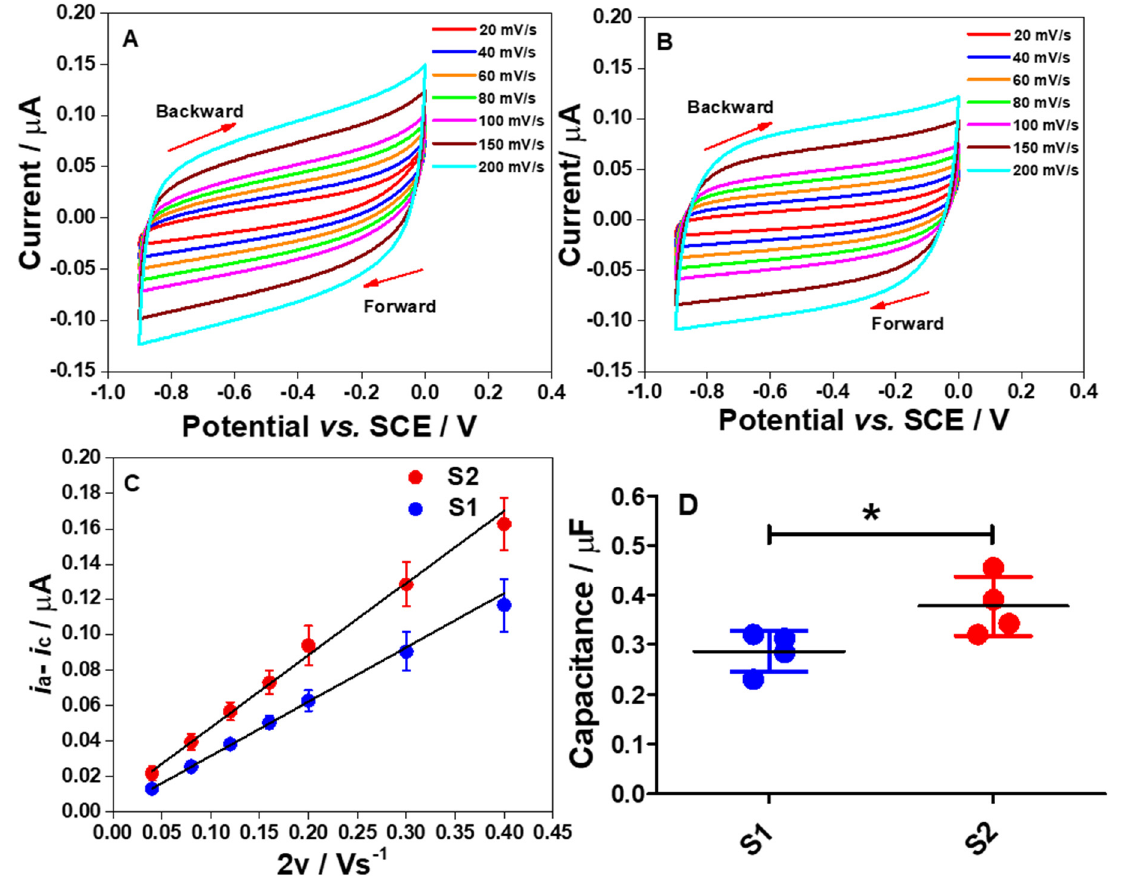
Figure 5. Cyclic voltammograms of S1 ( A ) and S2 ( B ) electrode strips in a purged 0.1 M PB solution of pH 7 at different scan rates from 20 to 200 mV s − 1 . Both electrodes were measured from 0 to − 0.9 V vs. SCE. ( C ) The plots of ∆ i vs. 2 v at − 0.5 V for the S1 and S2 electrodes to determine the C dl . ( D ) Comparison of the determined C dl values between the S1 and S2 electrodes. Statistical analysis was performed using an unpaired student t -test. Data shown as mean ± S.D., n = 4 and * denotes p < 0.05.